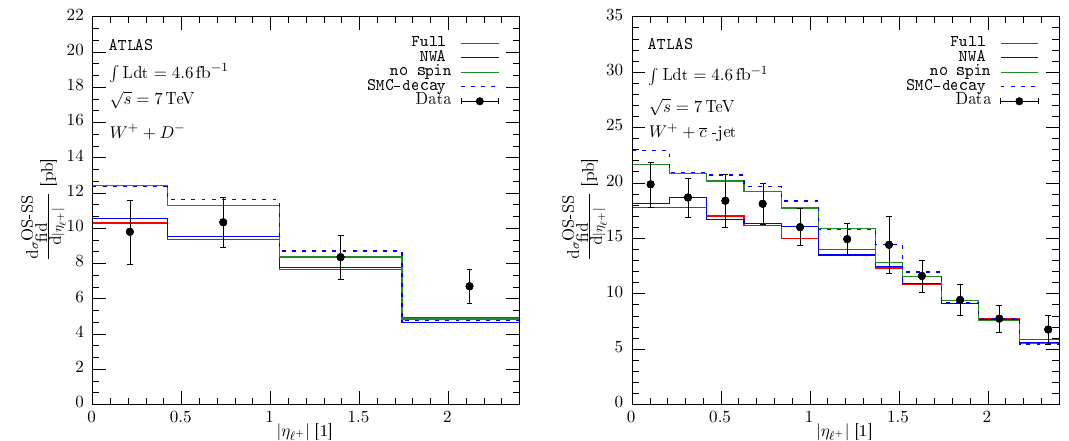
Figure 13 . Left: difference of the differential cross-sections for W + D -meson production, with W -boson decaying leptonically, from events with an ‘ + and a D ± -meson with charge of opposite sign (OS) and that from events with the ‘ + and a D ± -meson with charge of the same sign (SS), as a function of the absolute value of the ‘ + pseudorapidity. Theoretical predictions at NLO + SMC accuracy, obtained by PowHel + PYTHIA8 using different approximations, are compared to experimental data from the ATLAS collaboration [21]. In particular the results of the full simulation, including W off-shellness effects in PowHel , are compared to those with W decayed by PowHel in the NWA approximation including spin-correlation effects, to those in the NWA approximation neglecting spin-correlation effects, and to those where the W boson is kept as stable in PowHel and decayed by PYTHIA8 . The PYTHIA8 ATLAS A14 central tune with NNPDF2.3LO is used in all simulations. Right: same as in the left panel, but for the W + j c case.